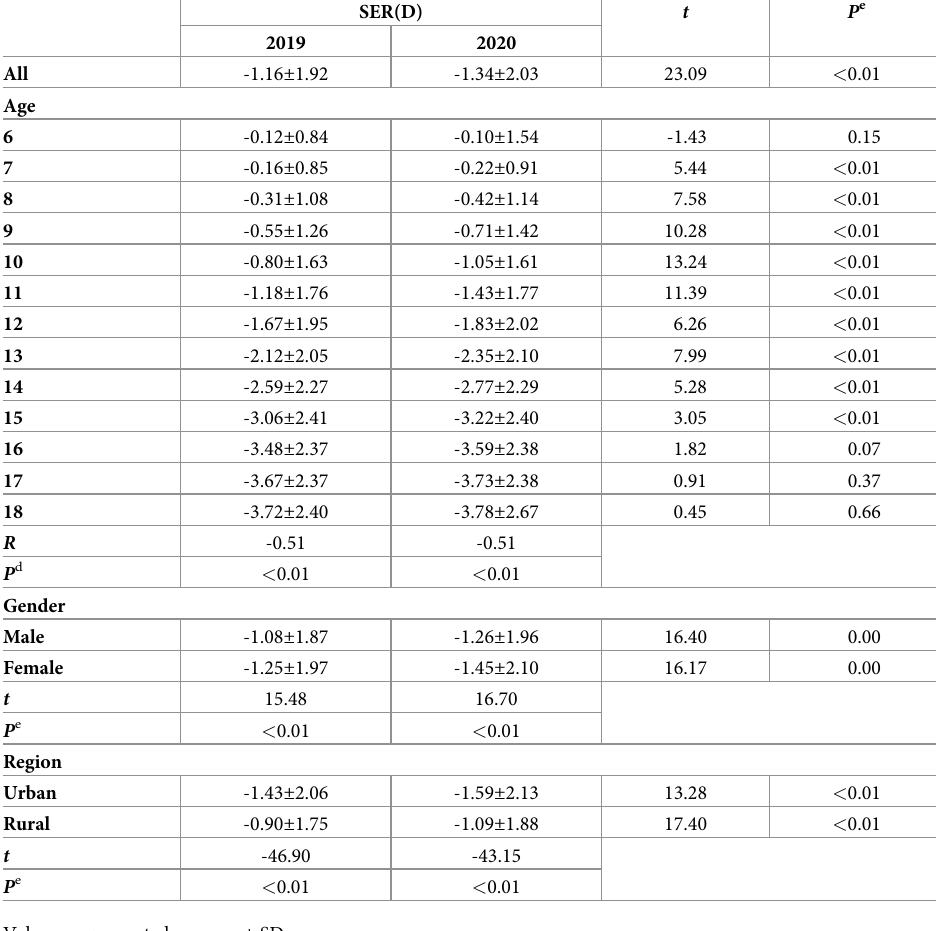
Values are presented as mean ± SD. d Comparison underwent Pearson’s correlation analysis. e Comparison underwent Two-proportions z